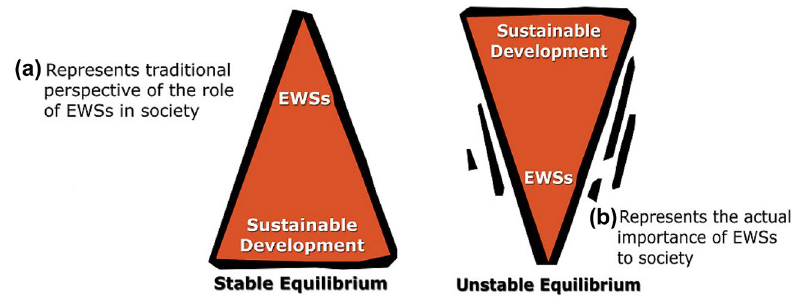
Fig. 9 The role of early warning systems (EWSs). a Represents a stable equilibrium and b represents an unstable equilibrium. Source Glantz